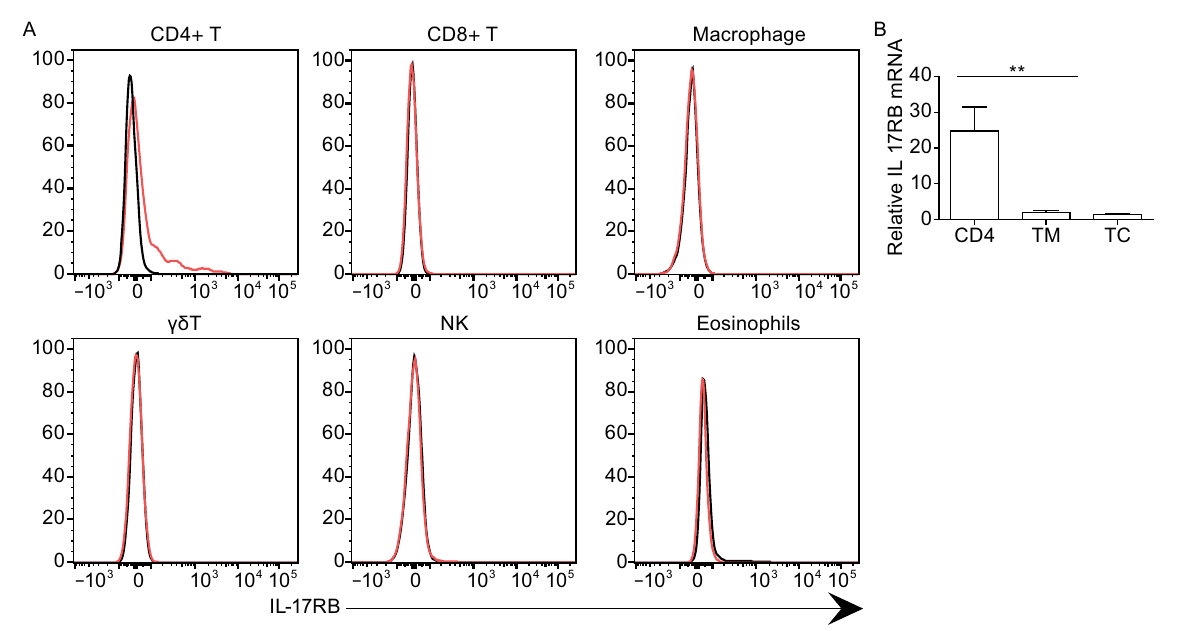
Figure 3. Expression of IL-17RB. The expression of IL-17RB was analyzed in mammary tumor-in fi ltrating cells isolated form the MMTV-PyMT primary tumor by fl ow cytometry (red) compared with isotype control (black) (A), or in sorted tumor in fi ltrating CD4 + (CD4:CD45+CD11b-CD3+CD4+) cells, macrophages (TM: CD45+CD11b+ F4/80+Gr-1-) and CD45- cells (TC) by relative mRNA